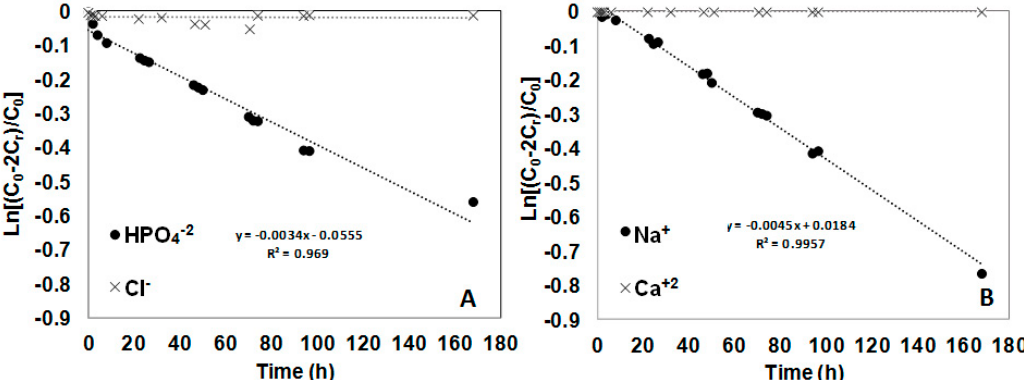
Figure 10. Plot of ln[(C 0 − 2C r ) / C 0 ] vs. operation time for the transport of the anions ( A ) and cations ( B ) of each nutrient through a PILIM based on 70% w / w of [MTOA + ][Cl − ]. Table 2. Permeability values of the polymer inclusion membranes based on the liquid [MTOA + ][Cl − ] on the transport of CaCl 2 and Na 2 HPO 4 .